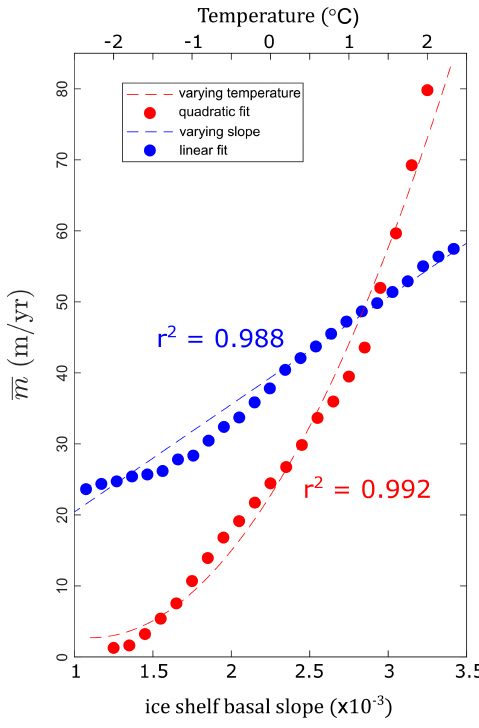
Figure 5. Area-averaged basal melt rate from MELTNET for an idealised ice-shelf geometry as a function of changes in ocean tem- perature (red) and ice-shelf basal slope (blue). Dashed lines show quadratic and linear fits to results, with corresponding r 2 values in matching